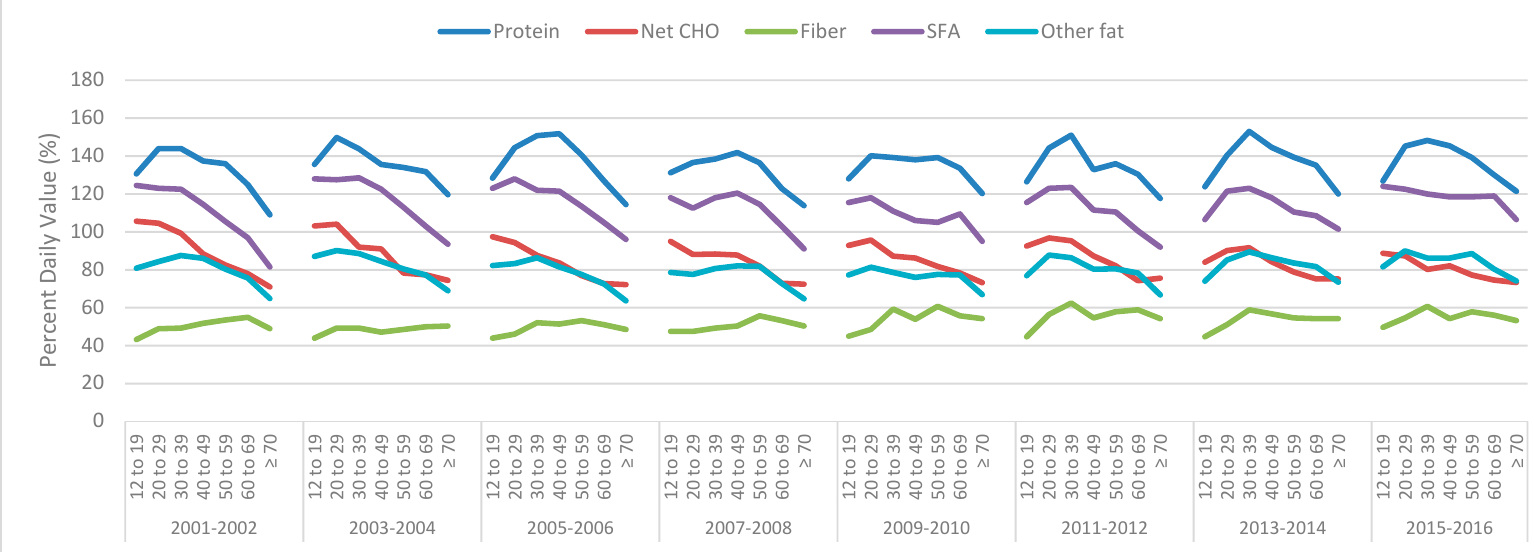
Figure 3. Mean daily female total protein, net carbohydrate (CHO), fiber, saturated fatty acids (SFA) and other fat intakes derived from National Health and Nutrition Examination Survey (NHANES) 2001–2016 data, across various age groups, as a percentage of the Daily Value (100% = Daily Value).